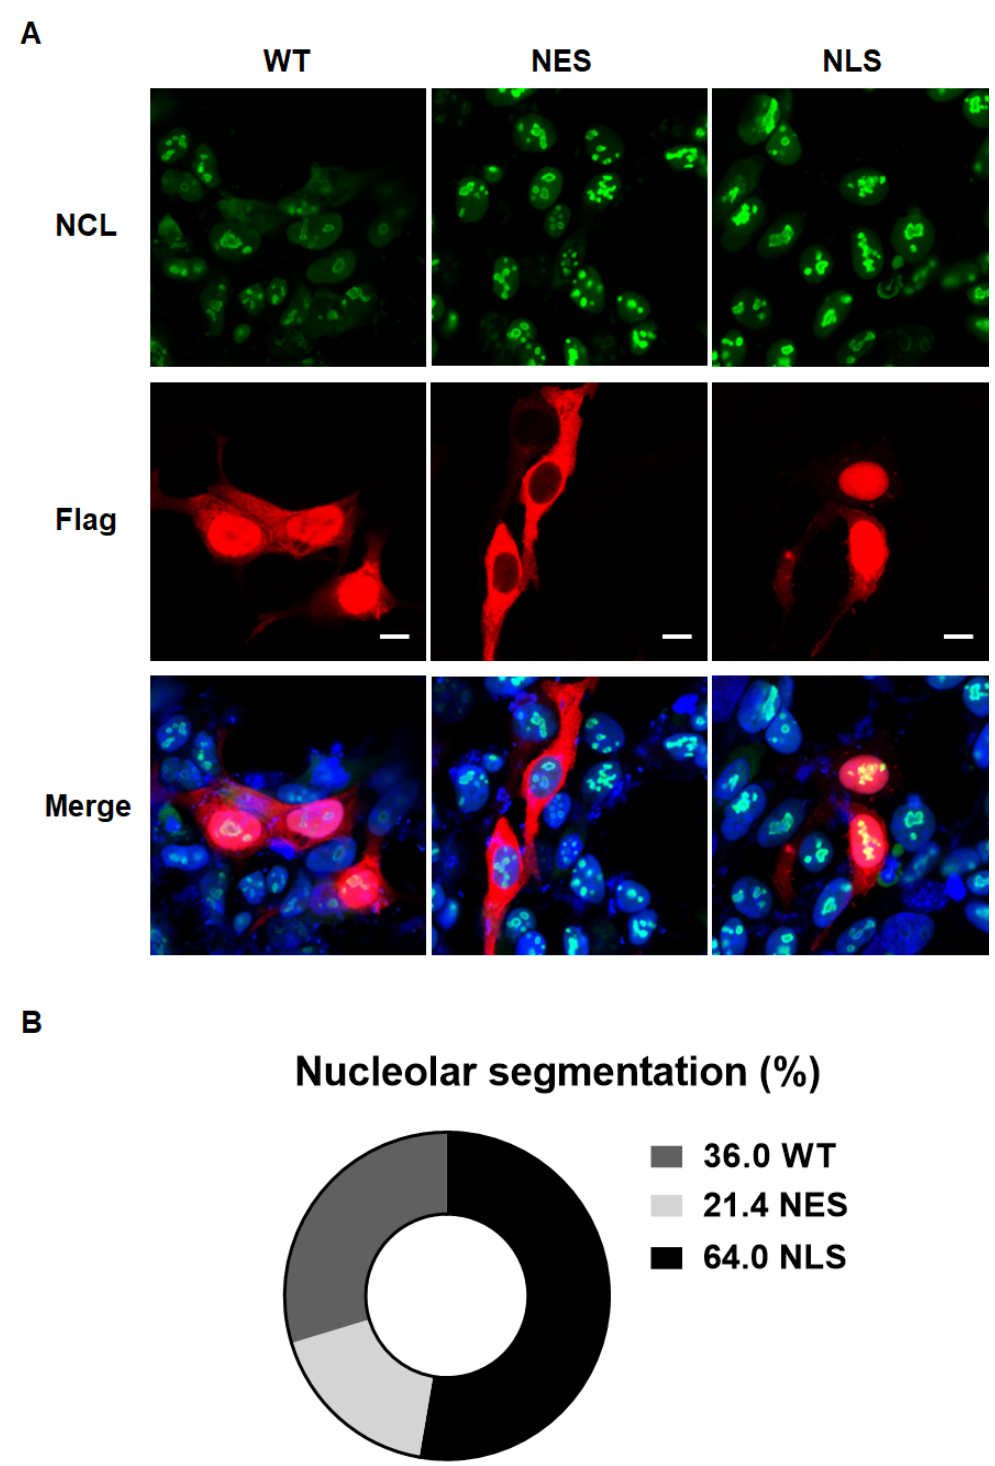
Figure 5. Nuclear localization of α Syn initiates the segmentation of nucleoli in MEF. ( A ) The morphology of nucleolus was analyzed using immunostaining of nucleolin (NCL) in MEF; green: endogenous NCL, red: Flag tag, blue: Hoechst33342. The number of cells with segmented NCL were counted by total transfected cells. ( B ) The transfection of MEF with nucleus-localized α Syn enhanced the segmentation of NCL-positive nucleoli. N = 4, number of cells = 15–18 per images (N); white bar: 5 μ m.